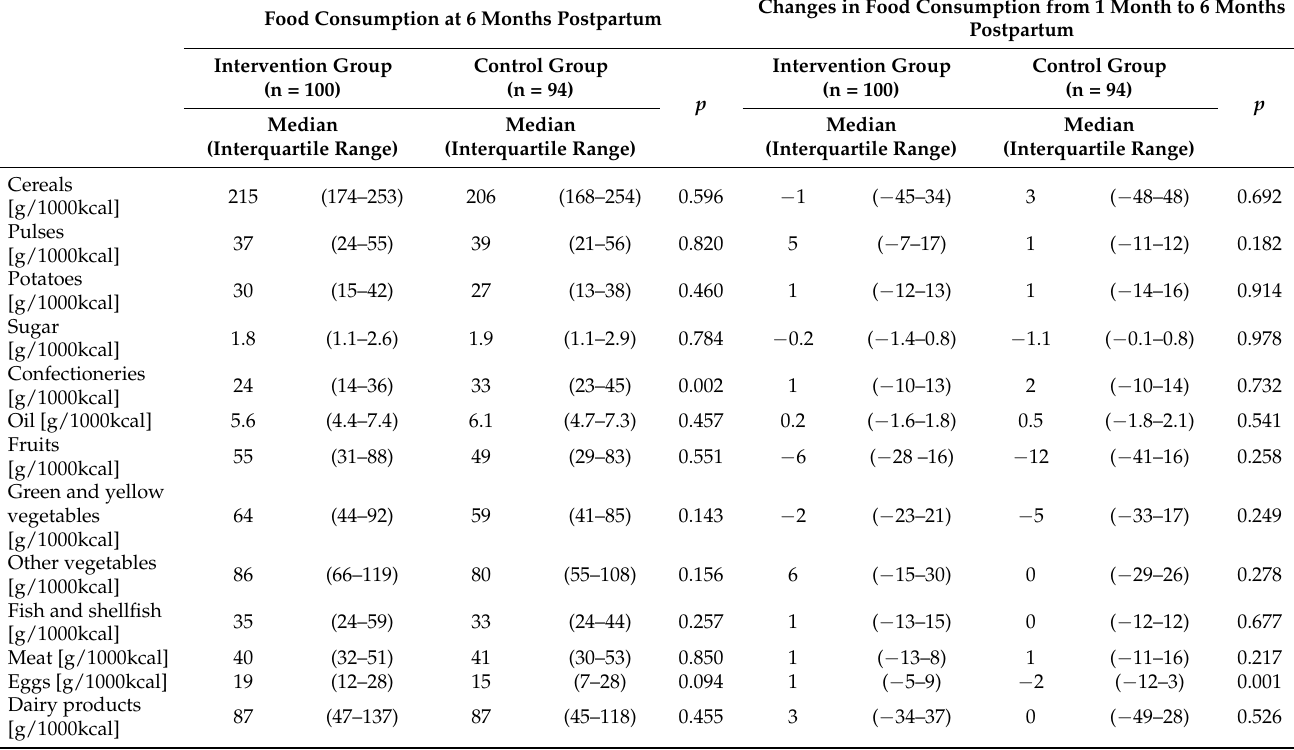
Table 5. Changes in food consumption from 1 month to 6 months